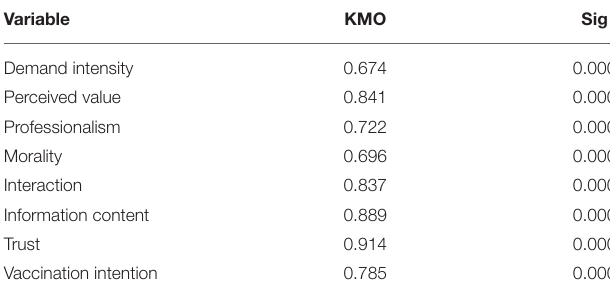
TABLE 3 | Variable KMO and Bartlett’s sphericity